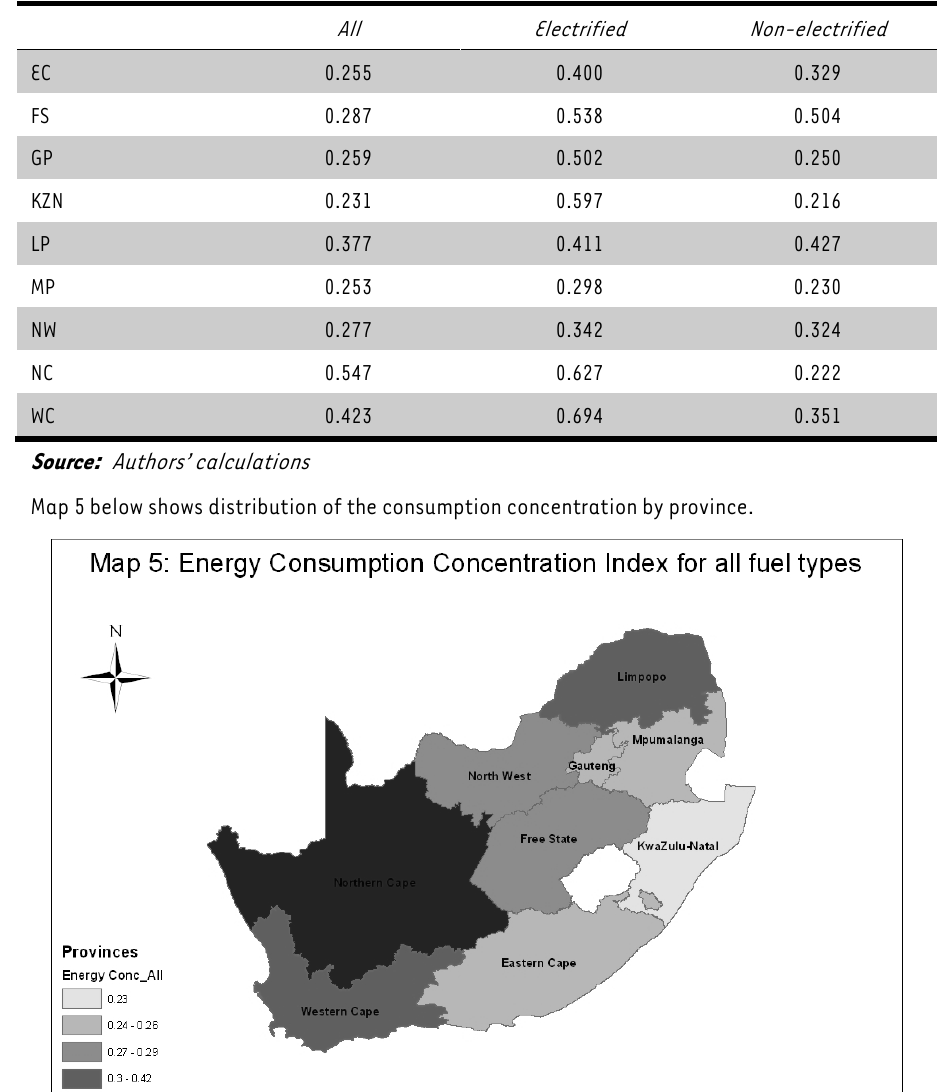
Consumption of Energy Concentration